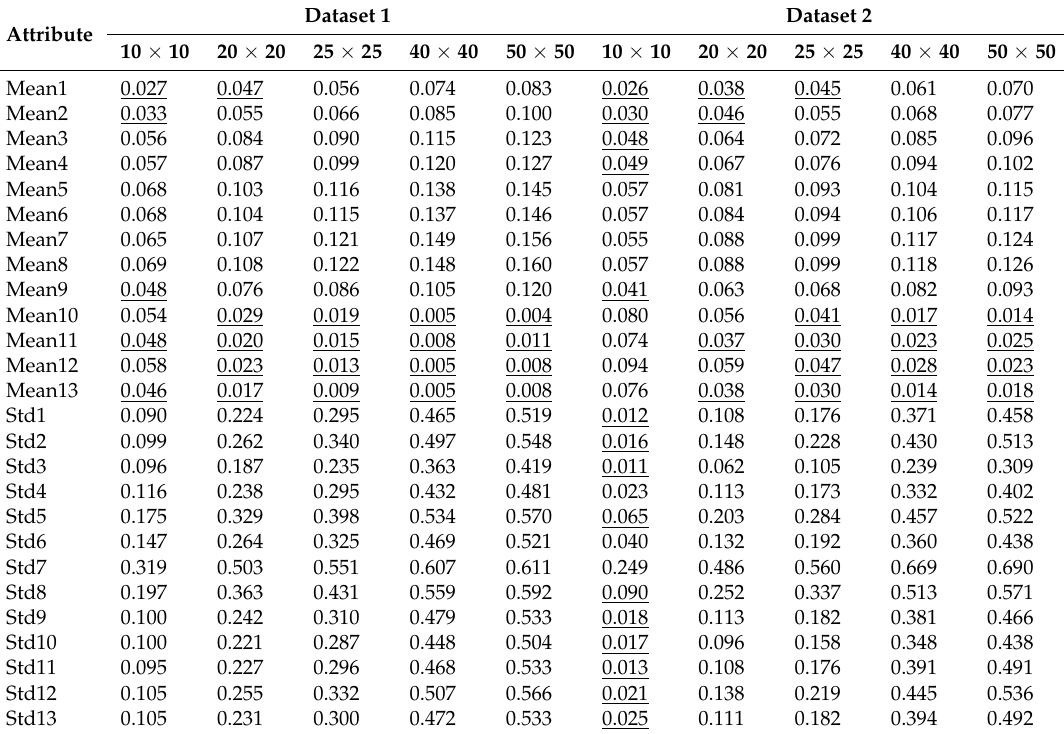
Table 4. Feature selection data for all sub-images.